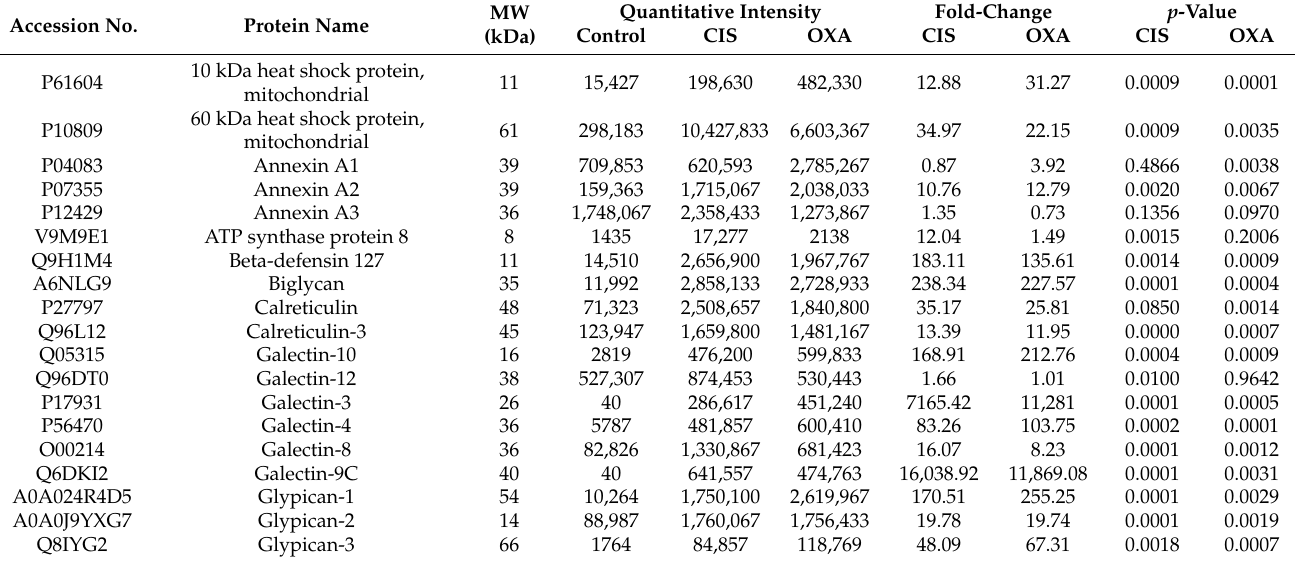
Table 1. Overexpression of DAMPs and DAMPs-related protein in cisplatin- and oxaliplatin-derived conditioned medium. Quantitative intensity of protein expression is mean of three